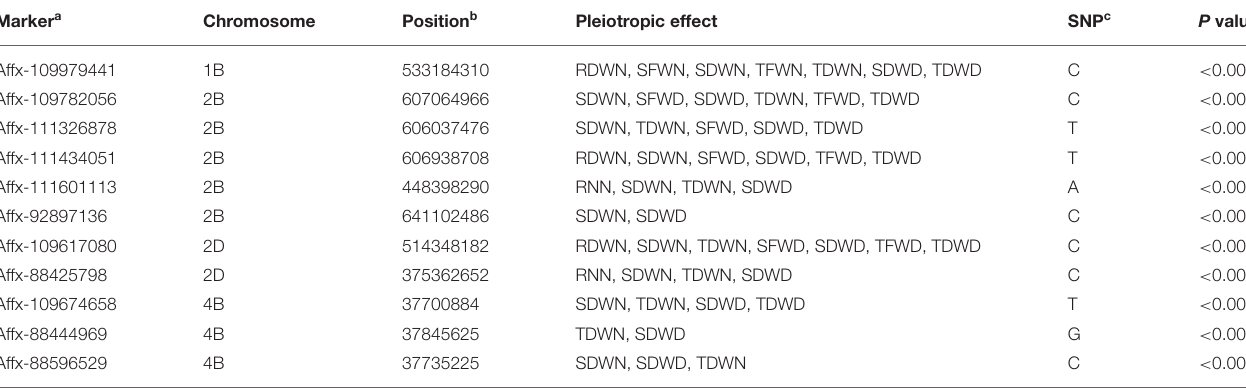
TABLE 2 | The SNP significantly associated with pleiotropic effect in different phenotyping traits in two environments. Marker a Chromosome Position